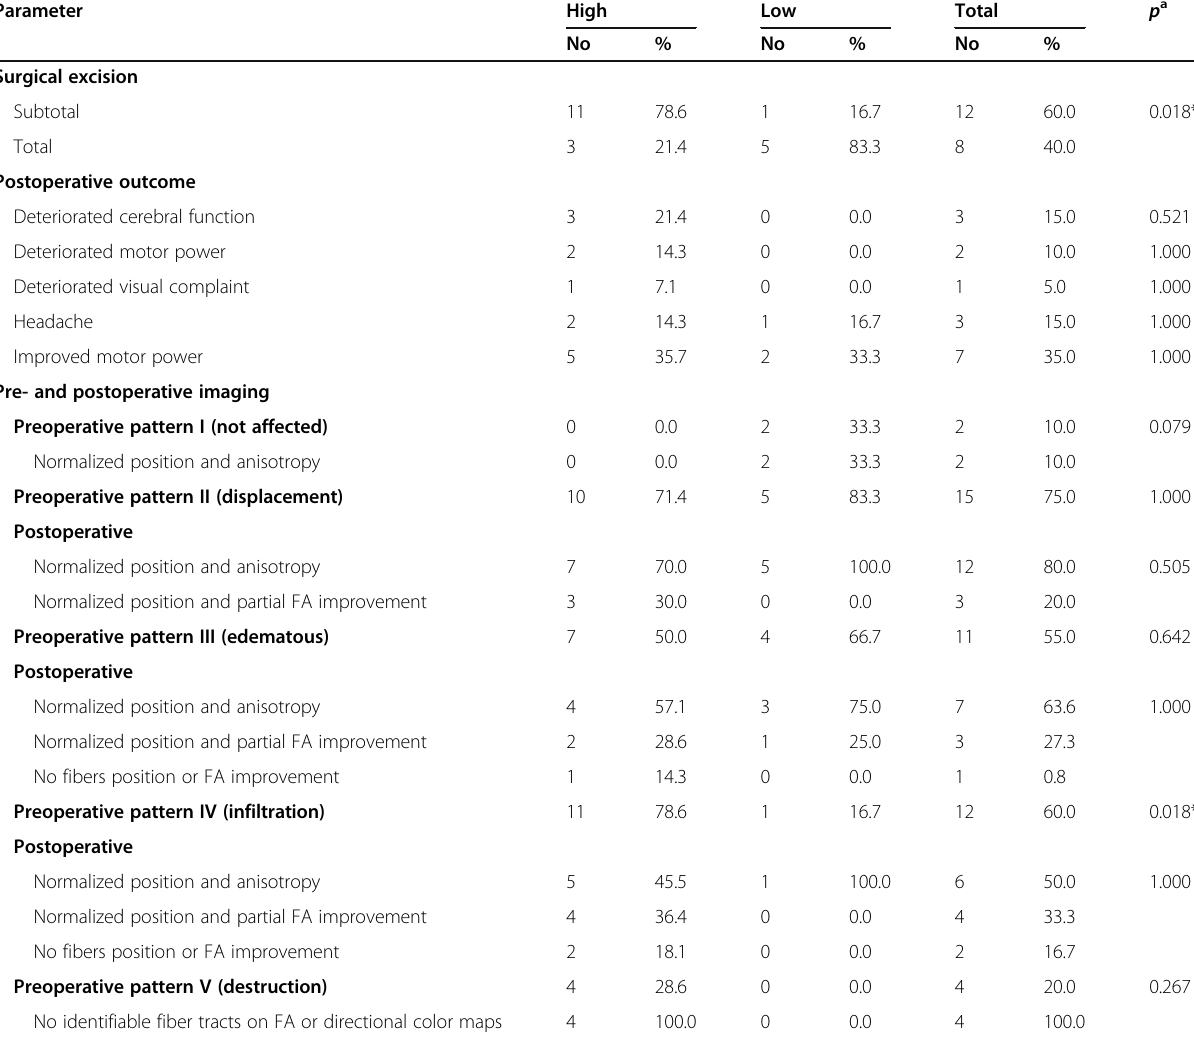
Table 3 Association between tumor grade and each of surgical excision and outcome (total n = 20)